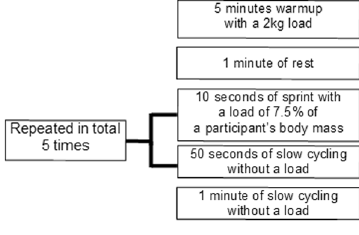
Figure 2. Acute exercise